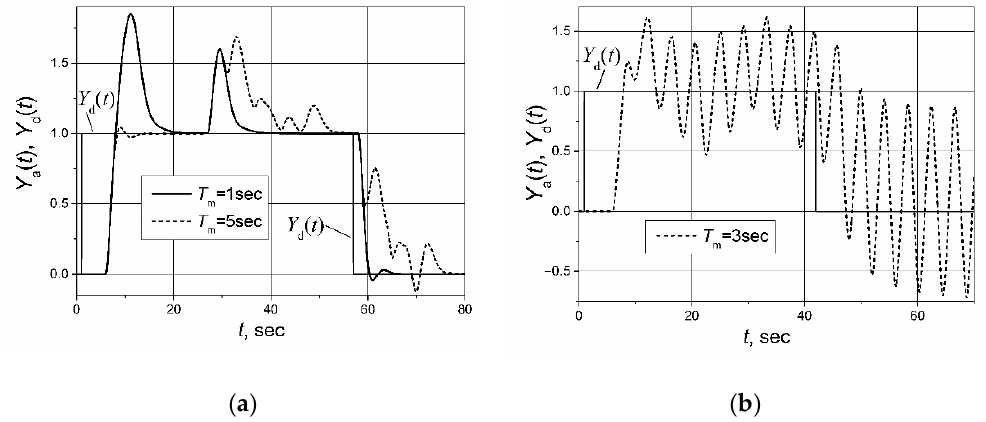
Figure 5. The set-point unit pulse and unit-load disturbance-response of the control system of the second-order plant with the transfer function G p (s) = 1/(s + 1) 2 and asymmetric response delays ( T r = 5 s, T f = 1 s) based on the PI controller with the classical Smith predictor when ( a ) the delay of the model is adjusted for the values T m = T r = 5 s and T m = T f = 1 s, ( b ) the delay of the model is adjusted for the value T m = ( T r + T f )/2 = 3 s. The unit-load disturbance occurs at the time moment t = 22 s.